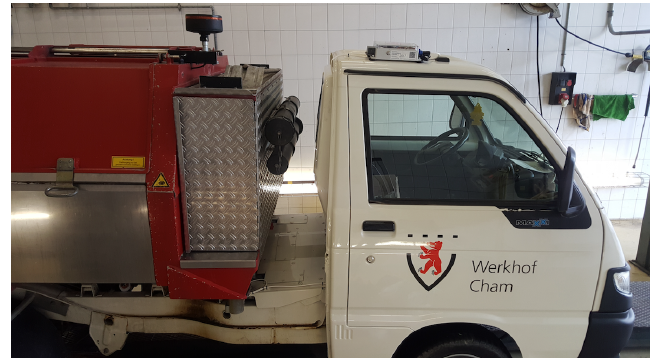
Figure 4. Sensor-box mounted on a utility vehicle from the municipality of Cham.